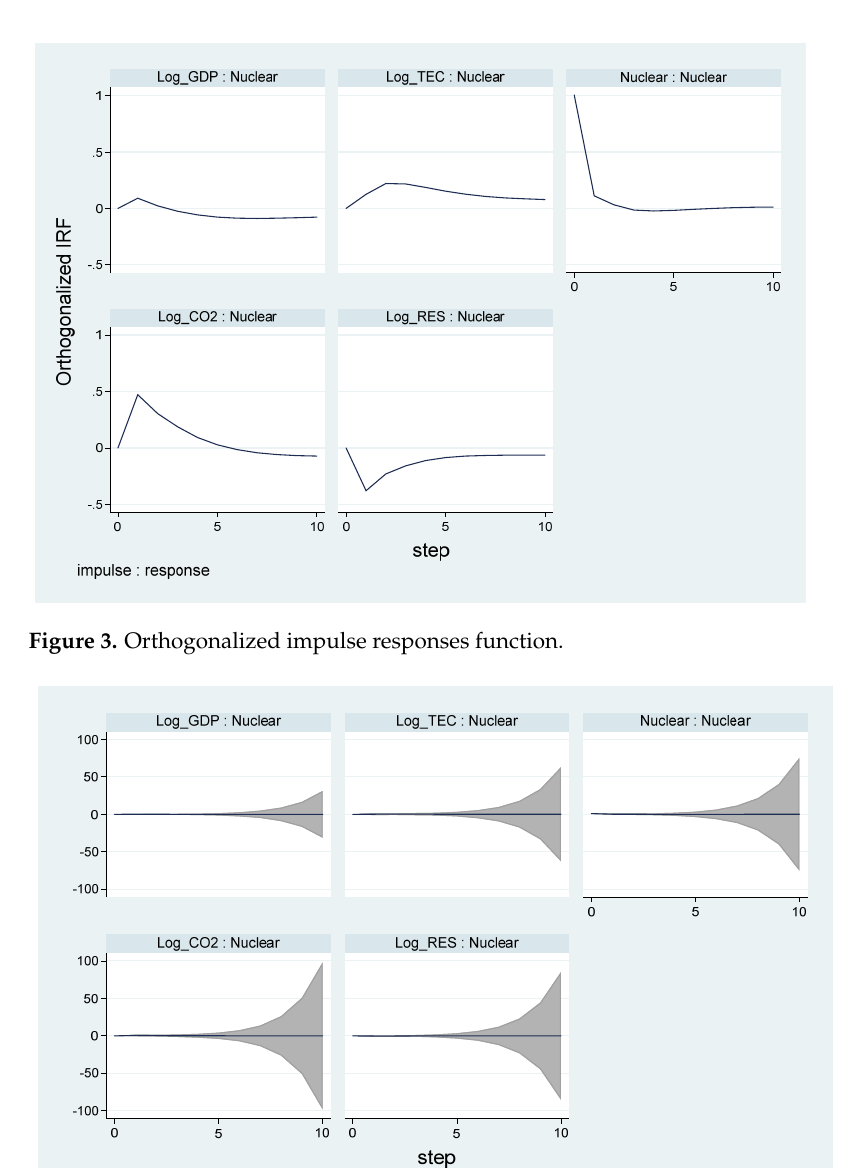
Figure 4. Confidence interval of orthogonalized impulse response functions.